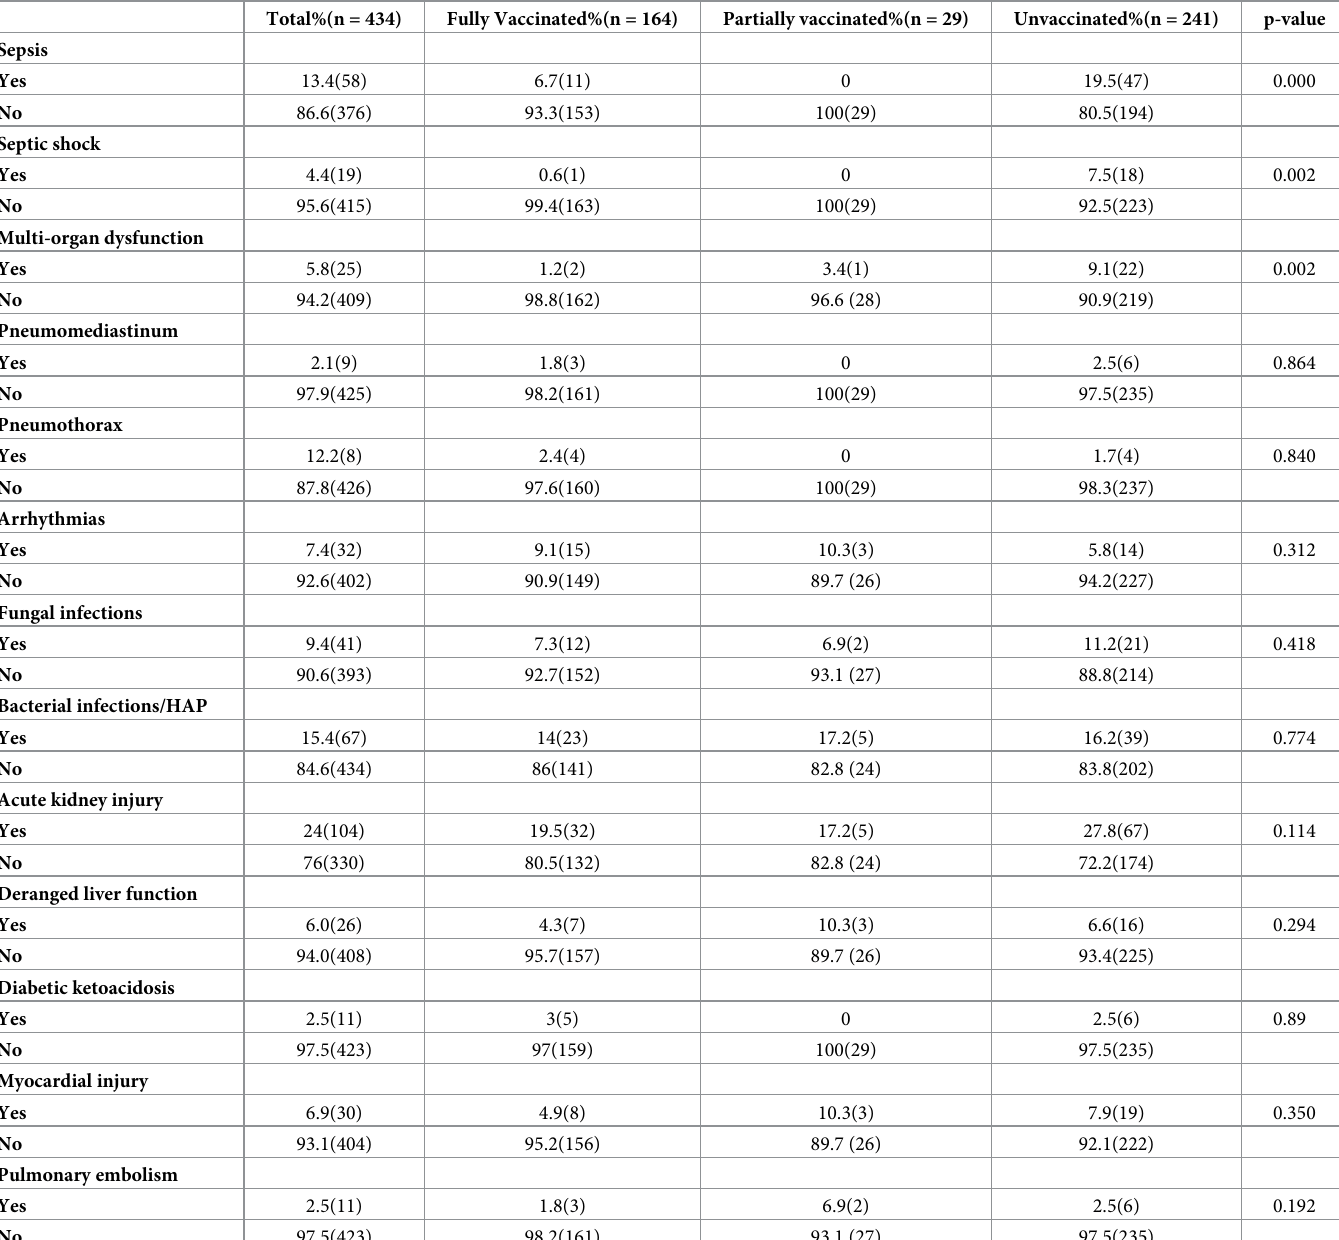
Table 7. Clinical complications of COVID-19 infection in vaccinated as compared to non-vaccinated patients. Total%(n =